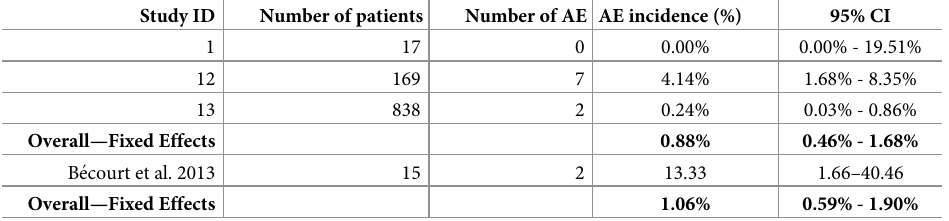
Table 3. Pooled AE incidence in children with Scabies, Crusted scabies, or participating in MDAs for scabies (excluding case studies) from a fixed effects logistic regression model. I 2 statistics (variation in log-odds attributable to heterogeneity) =